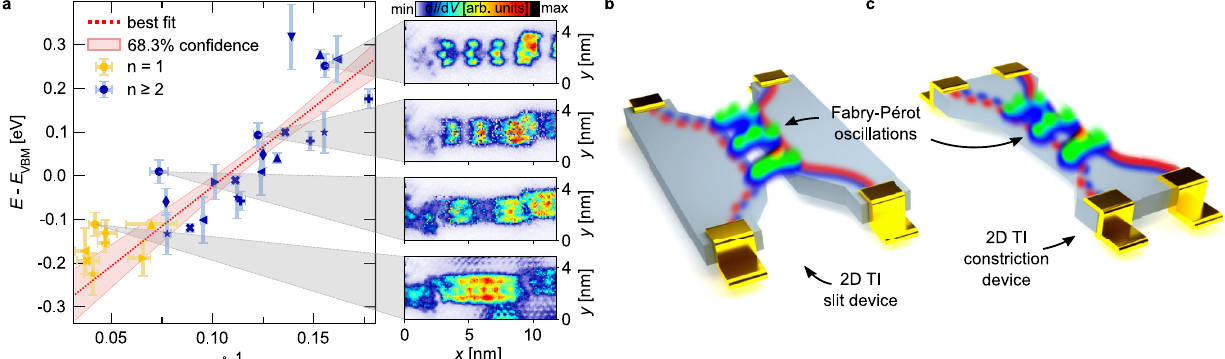
Fig. 4 Fabry-Pérot interferometry in a 2D TI nanoconstriction. a Fabry-Pérot resonator modes labeled by index n as a function of k = π / λ . The modes of equal DBs are assigned equal marker symbols. Red dotted line: Least squares fi t to the data for n ≥ 2 (see Methods for details). Red shaded region: 68.3% con fi dence bands of the fi t. The constant energy d I /d V maps on the right-hand side (taken from Fig. 3g) are assigned to the respective data points. The energy error bars re fl ect the s.d. related to the valence band onset ( E VB ) determination, see Supplementary Fig. S4. The k error bars for n ≥ 2 relate to the s.d. in determining λ . The k error bars for n = 1 relate to the estimated error in determining the length of the speci fi c DB. b , c Schematic four-terminal devices for electronic Fabry-Pérot interferometry based on a QSH insulator in slit or, alternatively, constriction